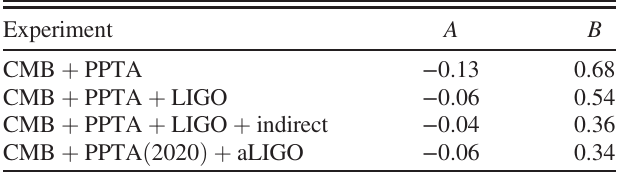
TABLE I. 95% C.L. upper limits on A and B as in Eq. (7). The value of B is therefore the 95% upper limit of n t at a reference value of r ¼ 0 . 11